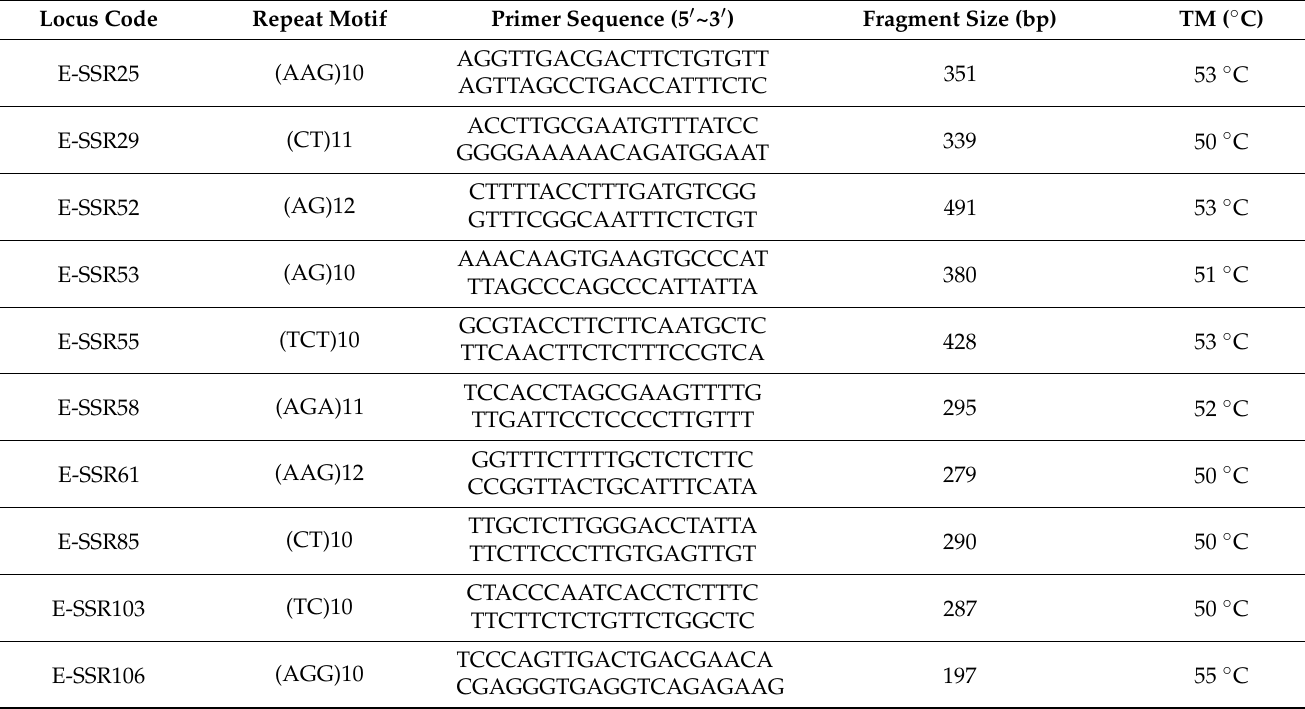
Table 2. Information on the 10 SSR